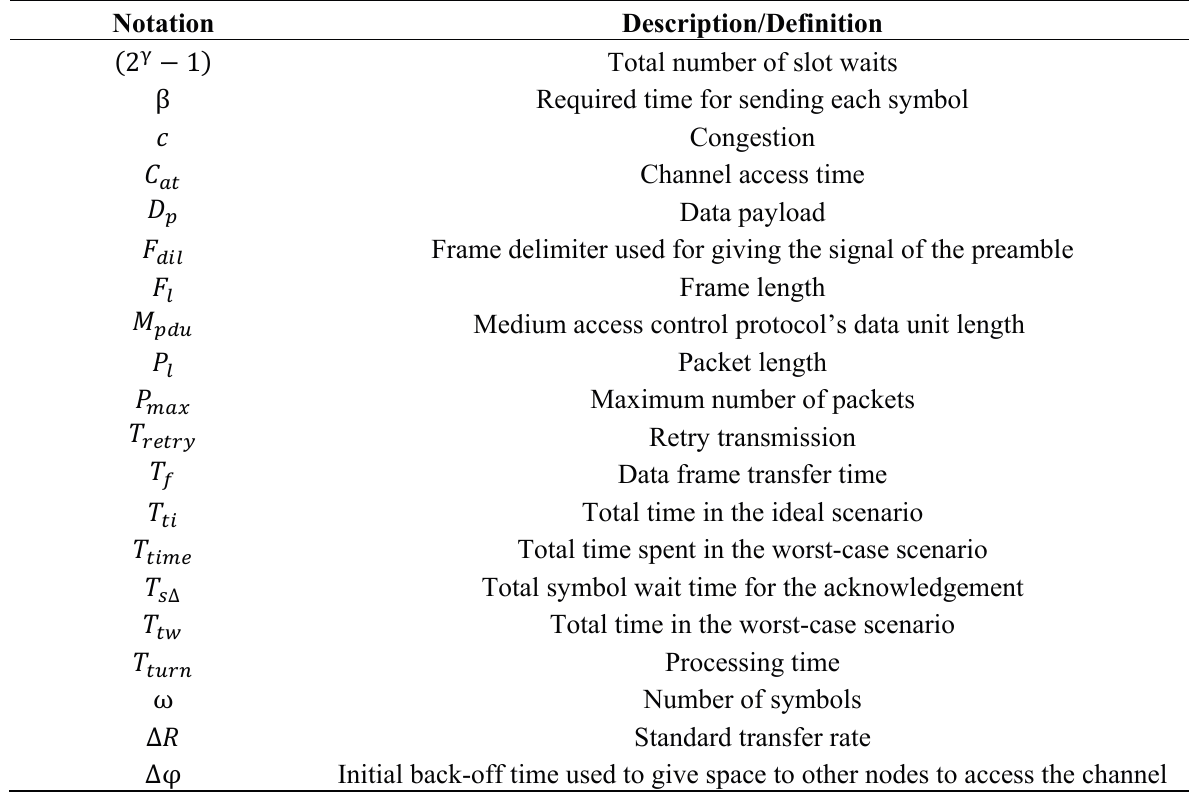
Table 2. Description of the notations used in the